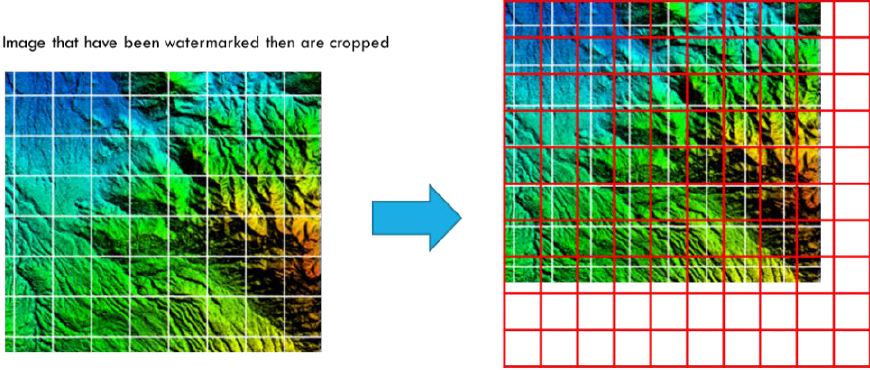
Figure 8. Watermark condition with different